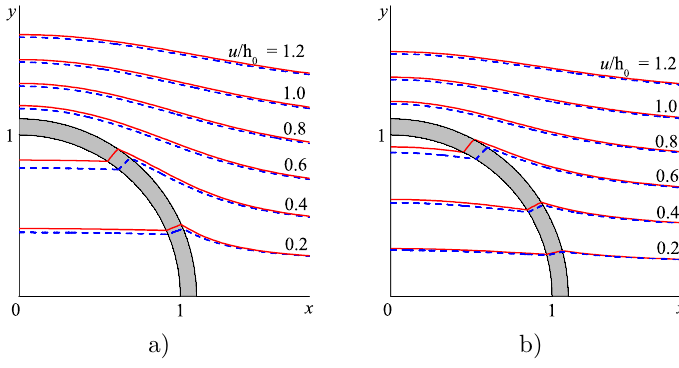
Figure 5. Isolines of the dimensionless magnetostatic potential u/h 0 for the dimensionless layer thickness δ = 1 . 1, the Langevin susceptibility χ L = 7 . 61, the dimensionless applied magnetic-field intensity h 0 = 1 (a) and h 0 = 3 (b). Dashed isolines correspond to model 2. Solid isolines correspond to model